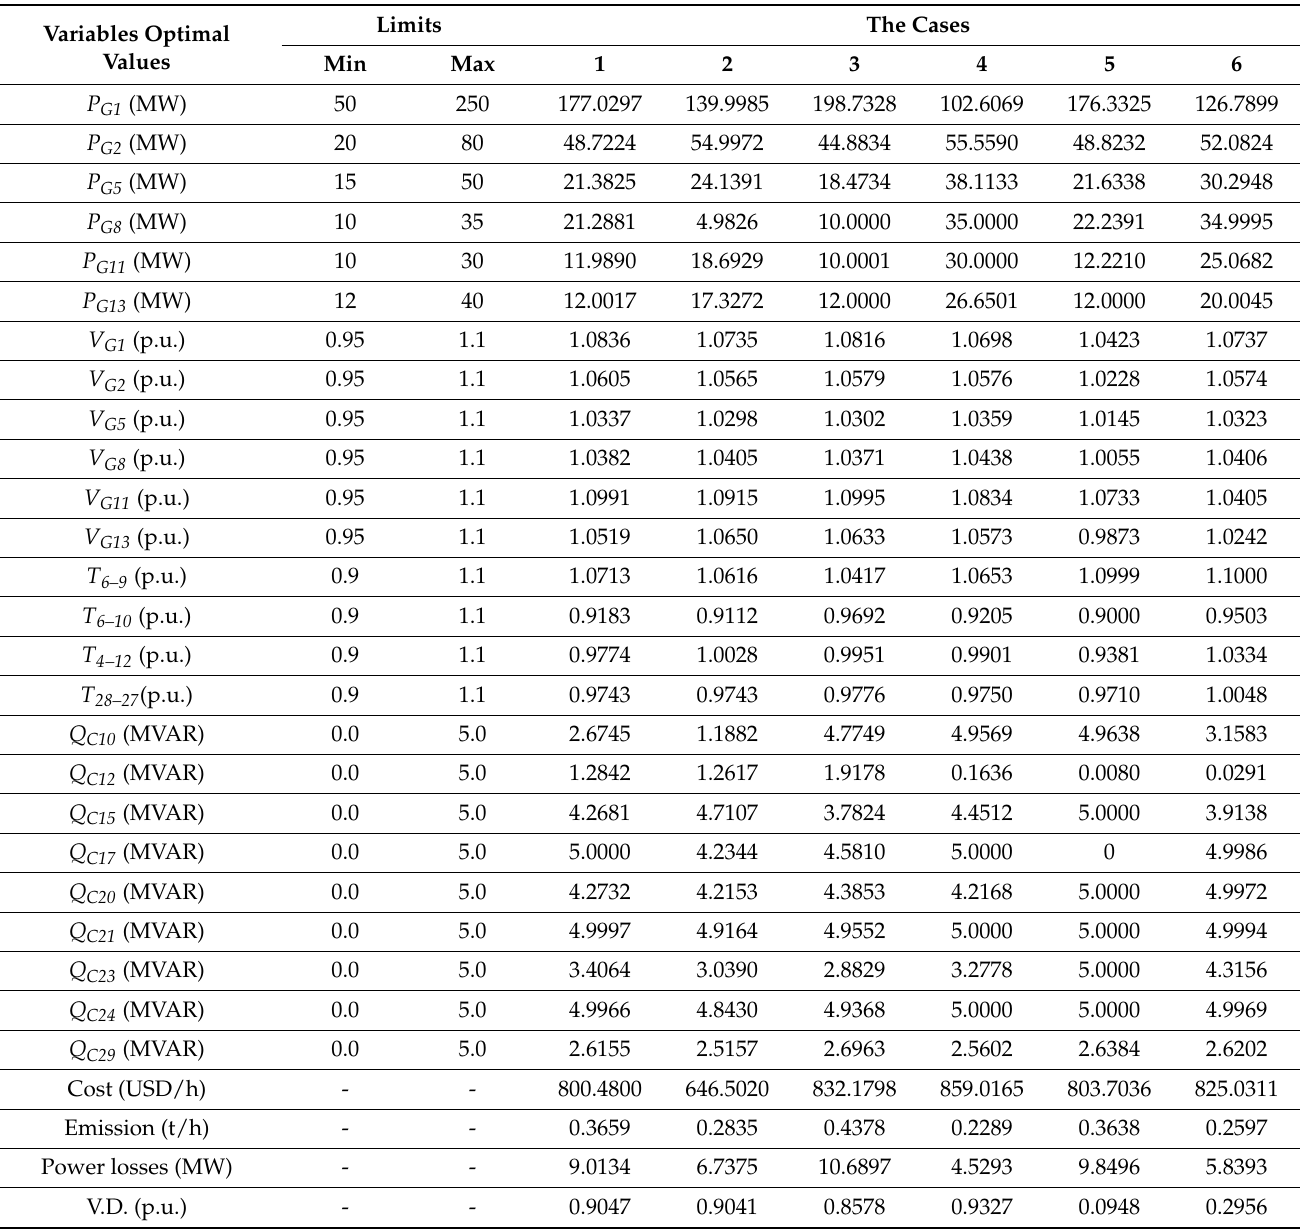
Table 2. The optimal values for the six cases by